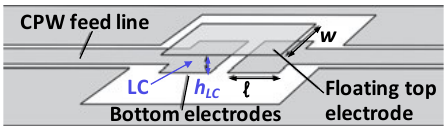
Figure 11. Schematic of an LC varactor with a floating top electrode and bottom electrodes, forming the two plates of the capacitor with distance h LC , where later LC is filled in.